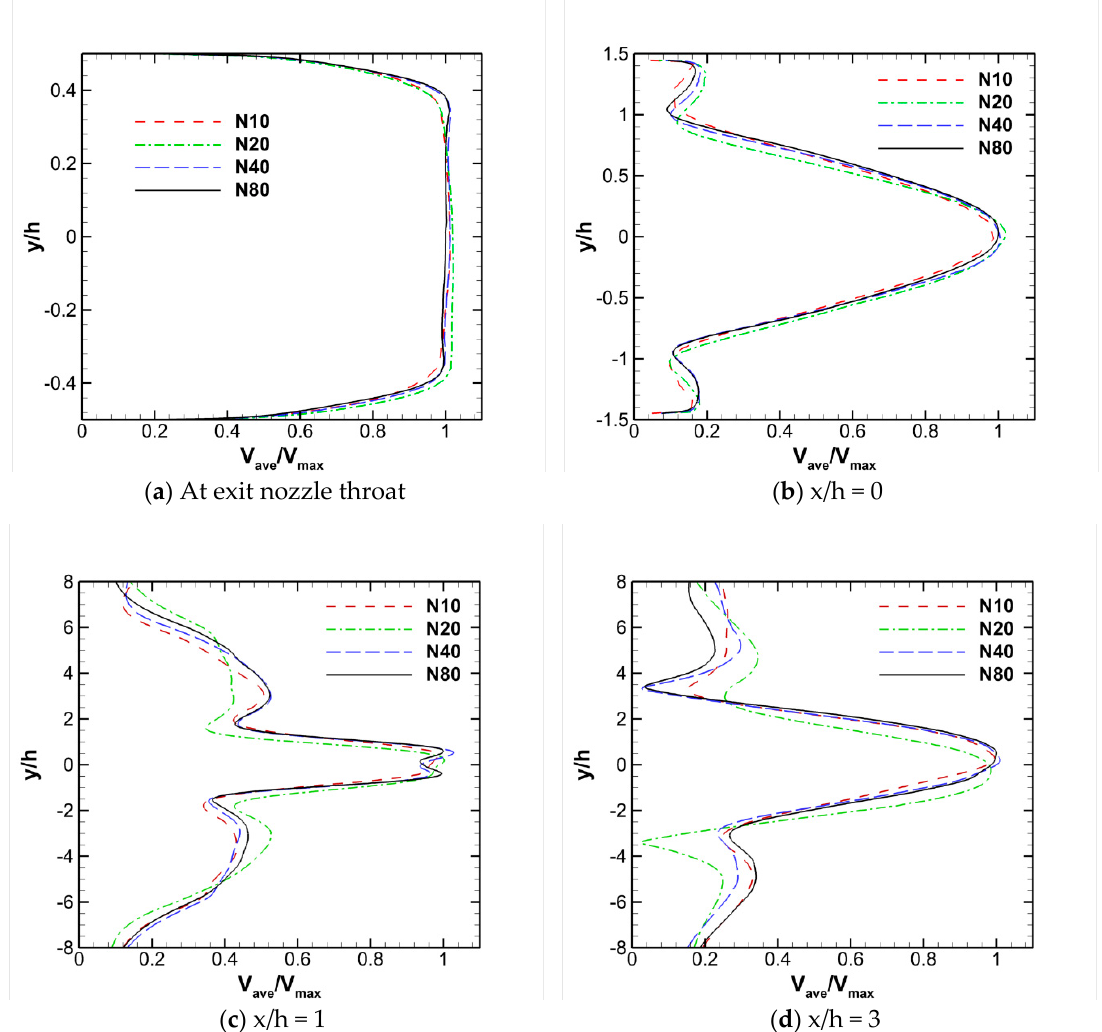
Figure 6. Time-averaged velocity magnitude profiles at various x/h locations.